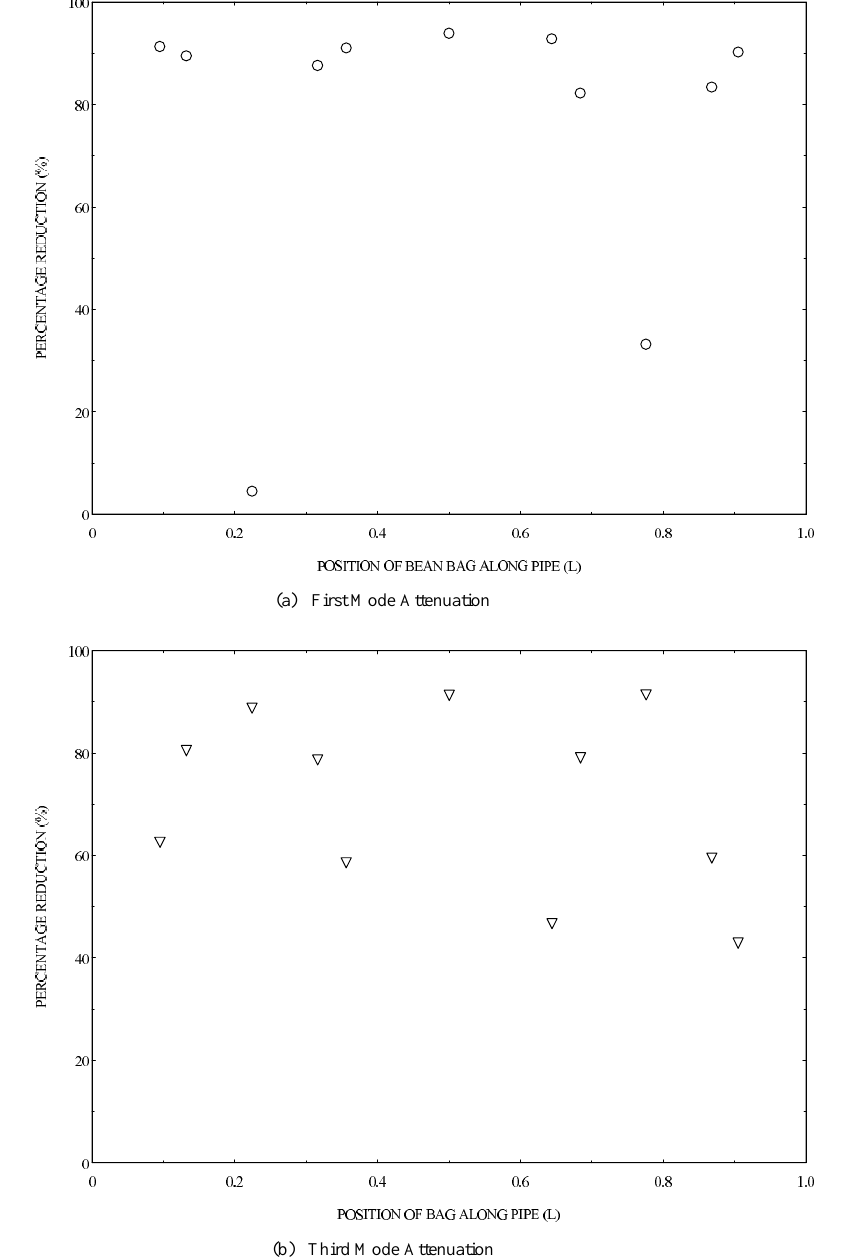
Fig. 6. Variation of vibration reduction with position of